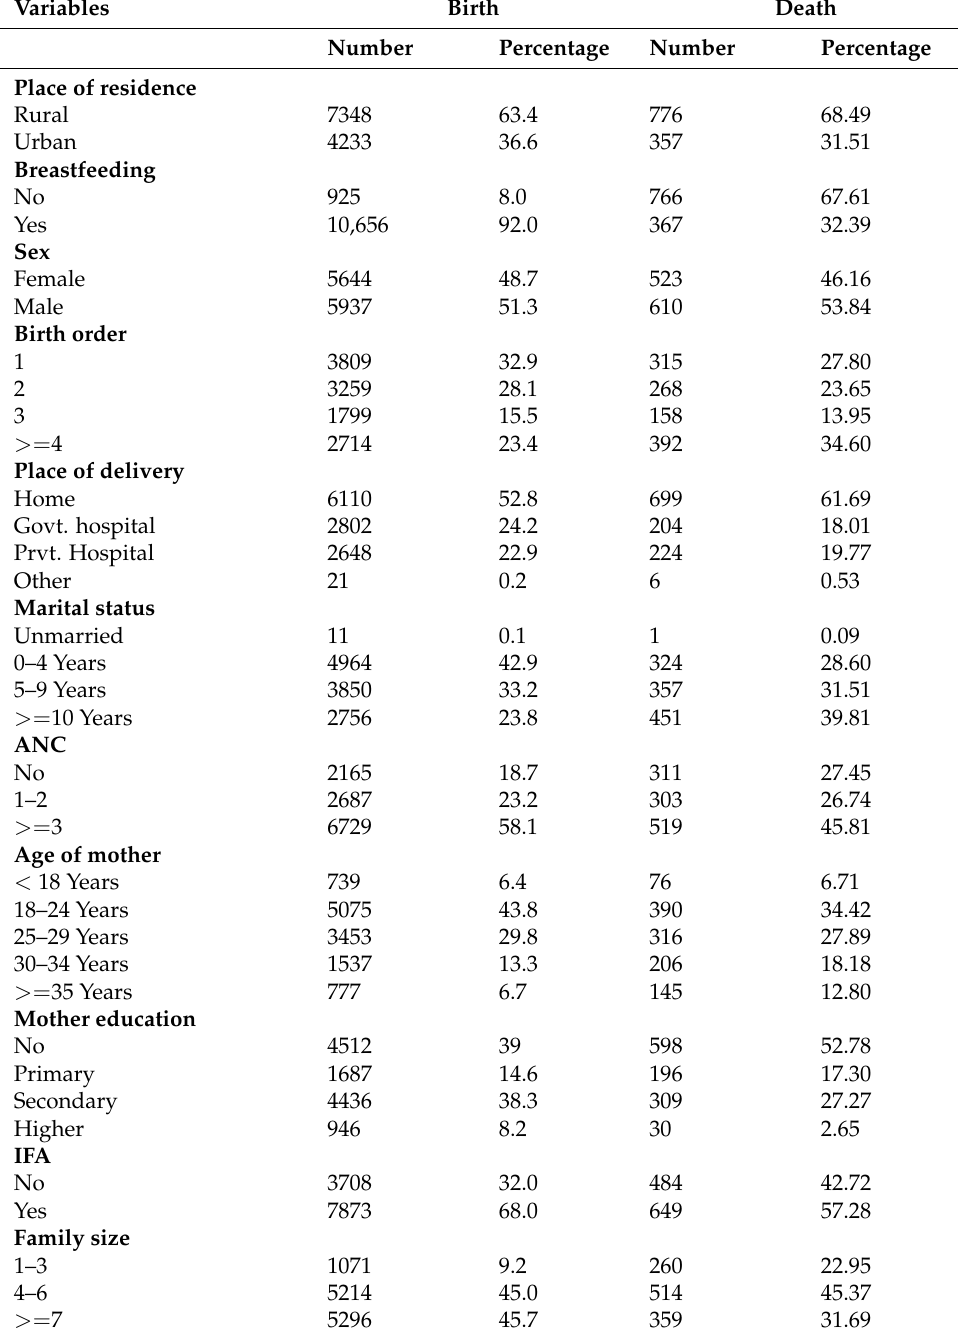
Table 4. Descriptive statistics of NFHS